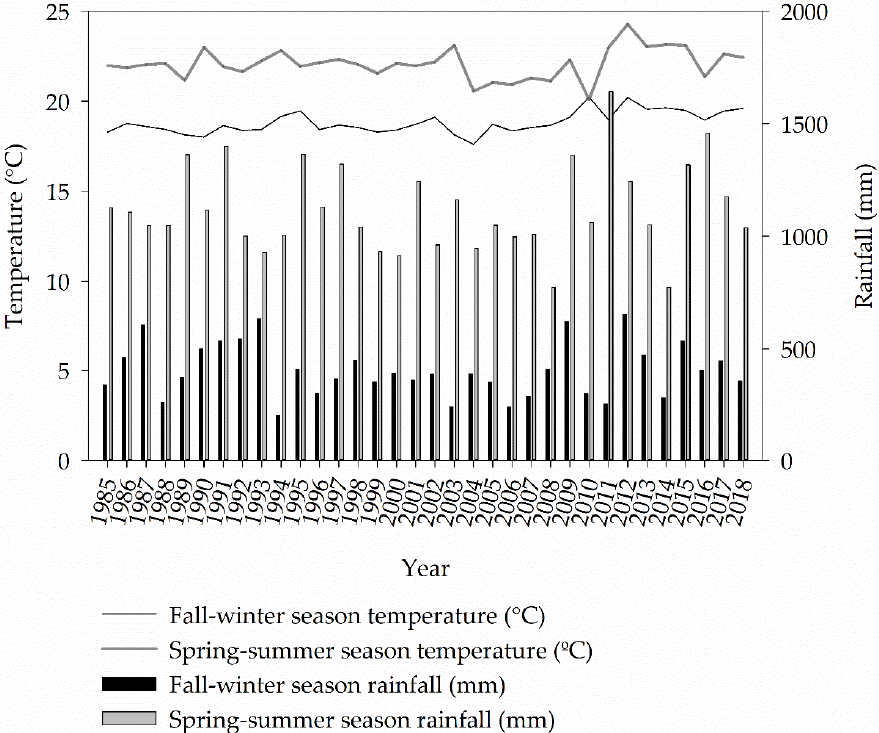
Figure 1. Means of temperature and rainfall in fall–winter and spring—summer seasons since experiment implementation (1985–2018).